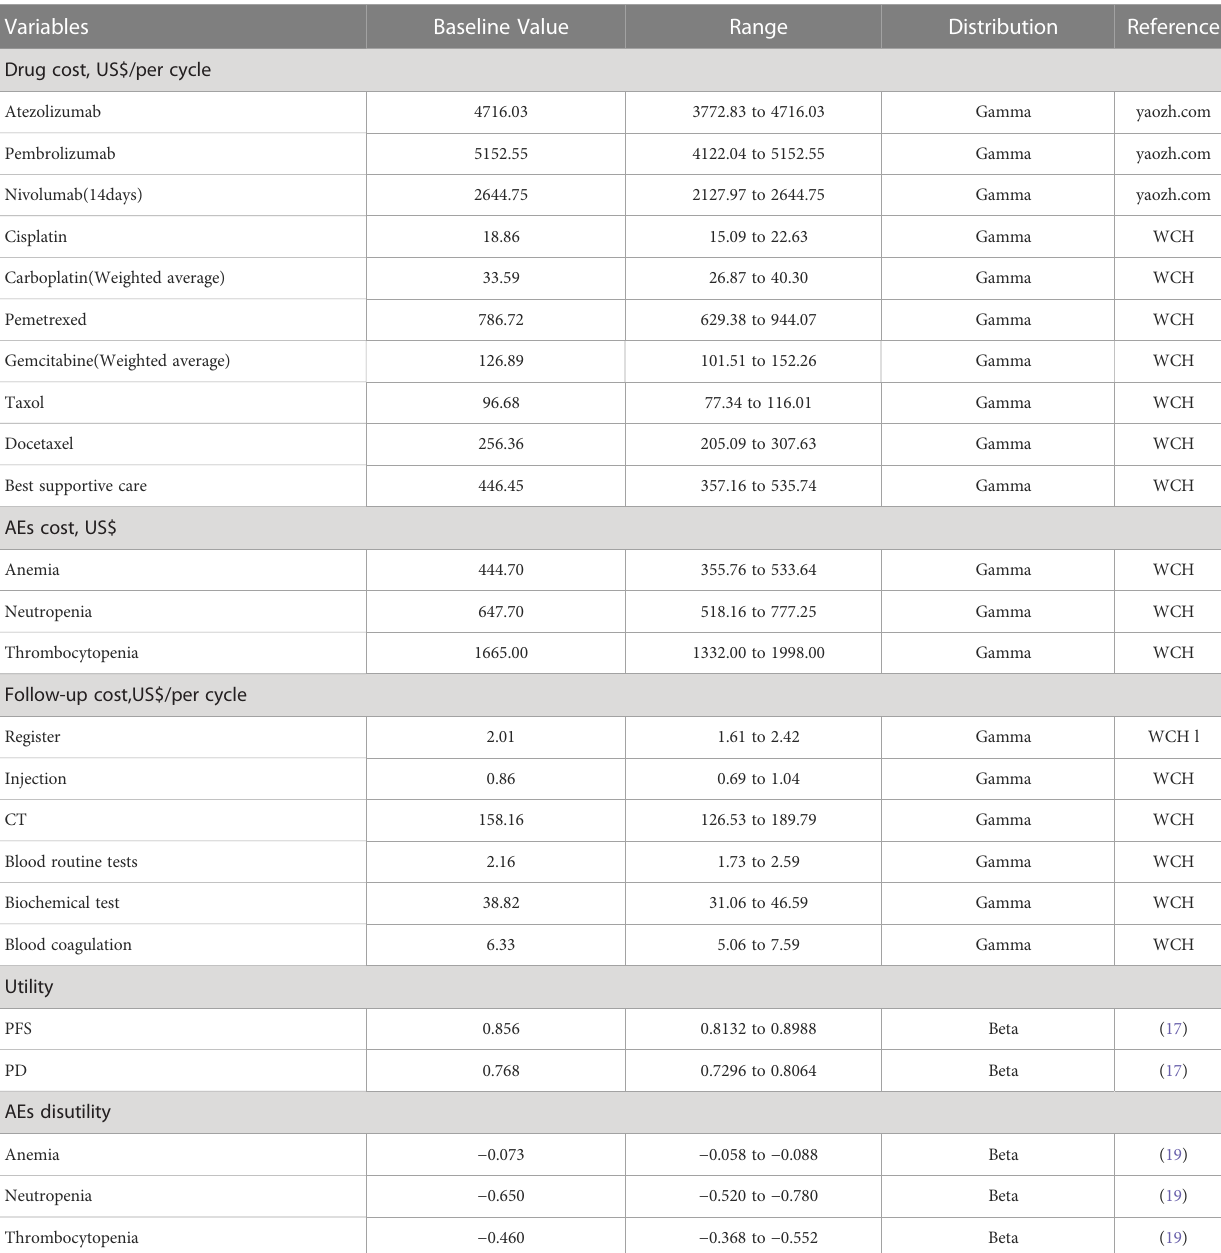
TABLE 2 Model parameters: base-line values, ranges, and distributions for sensitivity analyses. Variables Baseline Value Range Distribution